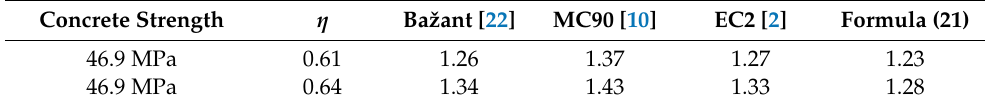
Table 5. Nonlinear amplification coefficient proposed by scholars.